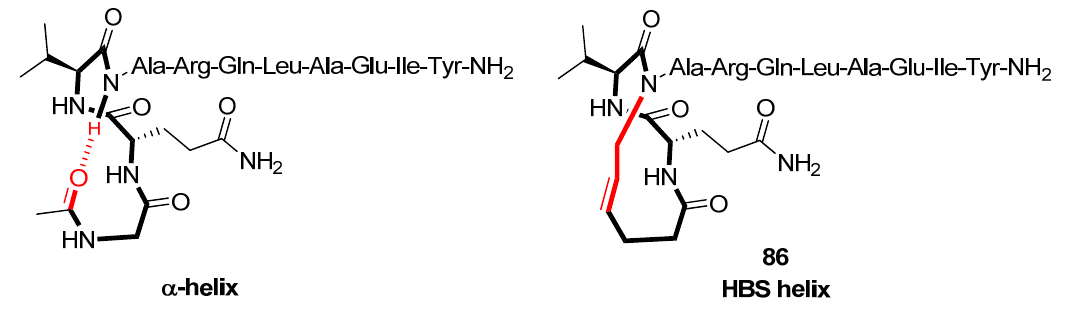
Structural studies by CD spectroscopy [92], NMR spectroscopy (amide NH temperature